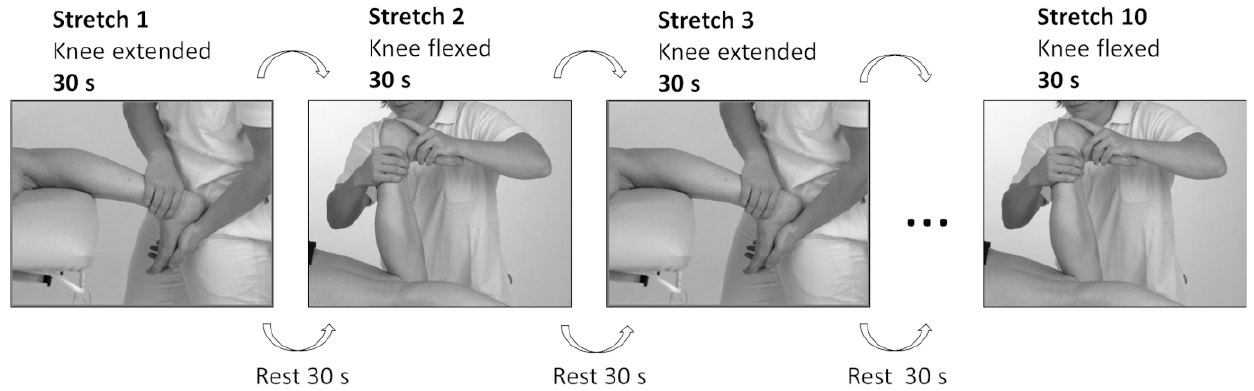
Figure 2. Stretching procedure.